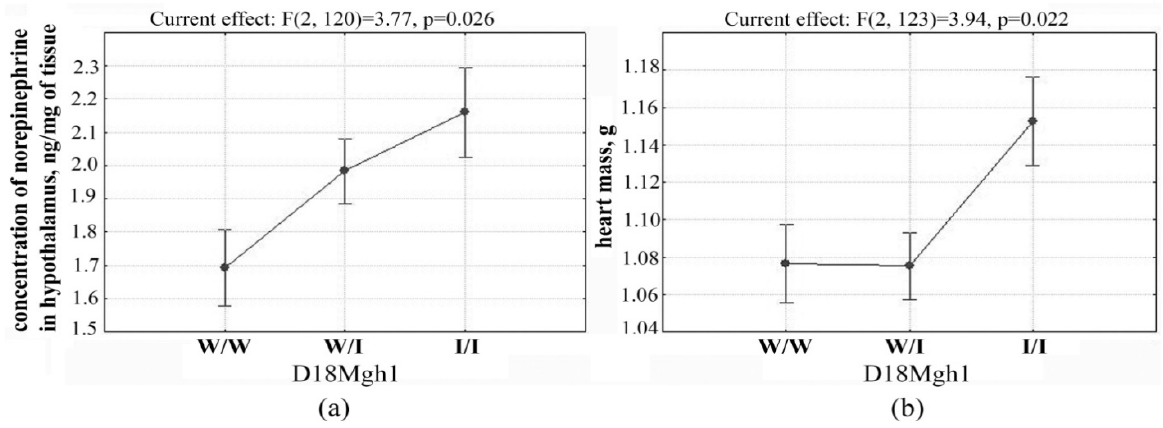
Figure 3. Allele effects on trait values in the QTL on chromosome 18 in the region of marker D18Mgh1: ( a ) concentration of norepinephrine in the hypothalamus; ( b ) heart mass; I/I—a homozygote for the ISIAH allele; W/W—a homozygote for the WAG allele; I/W—a heterozygote.